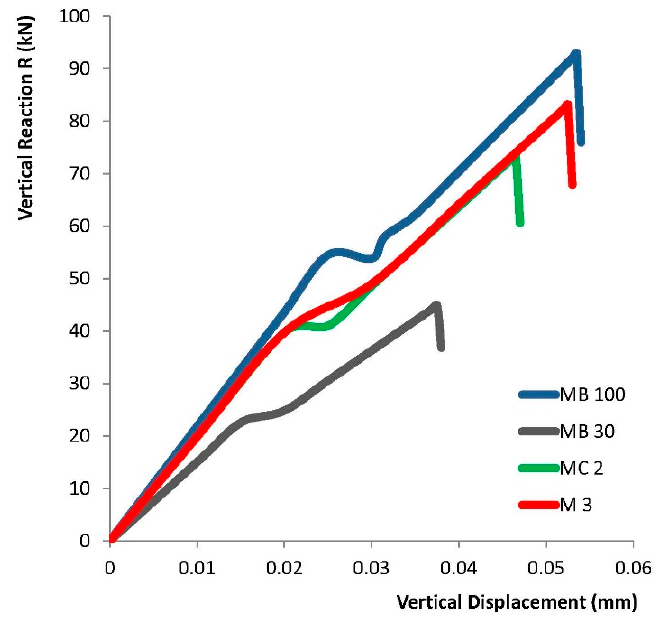
Figure 10. Load-displacement curves for concrete series. Table 7. Summary of experimental and numerical results for ultimate load for concrete series. Experimental